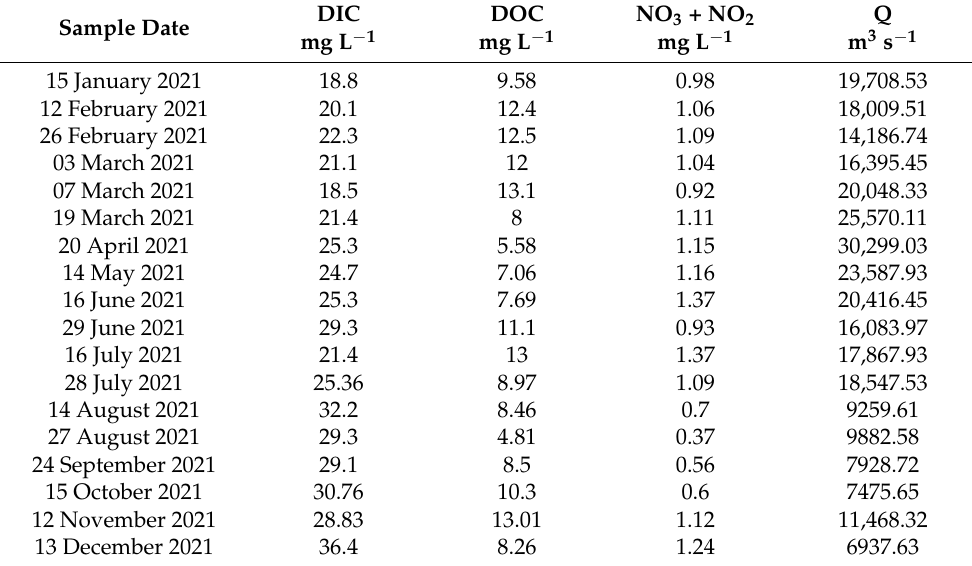
Table 2. DIC, DOC, NO 3 and NO 2 and river discharge across all sample